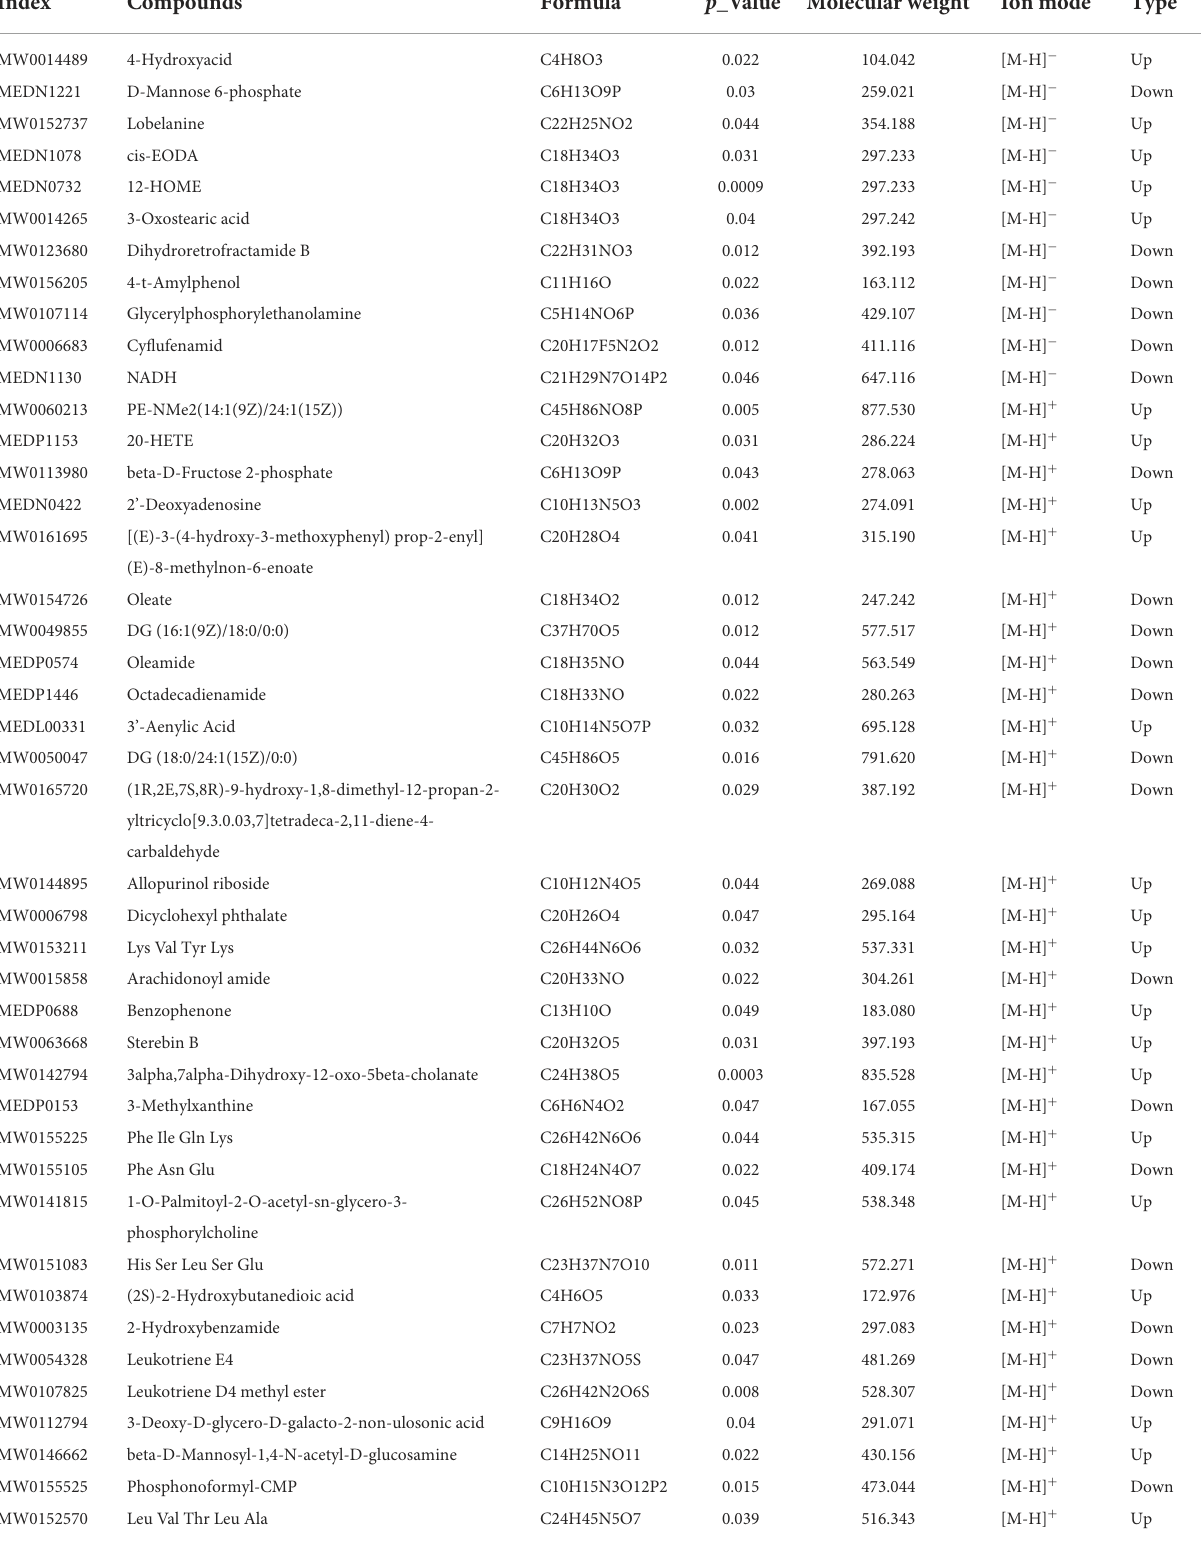
TABLE 2 Differential metabolites between the T2D + SP group and T2D